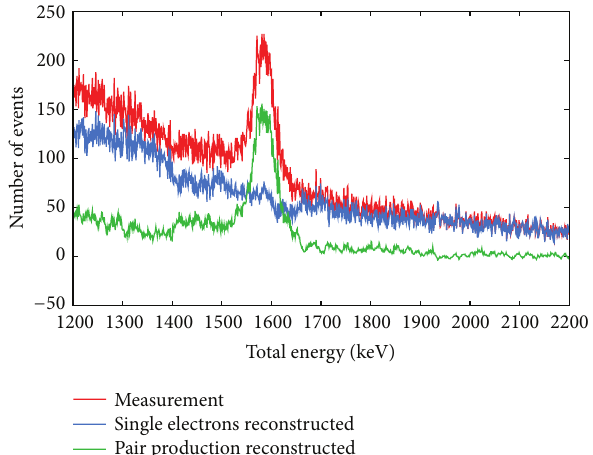
Figure 4: Red: reconstructed distribution of measured total energy depositions in tracks of a 1mm thick CdTe Timepix detector with 110 𝜇 m pixel pitch for irradiation with 2.614 MeV photons through its edge. Straight line tracks caused by muons and circular track structures caused by 𝛼 -particles have been removed before track analysis with the artificial neural network. Green: reconstructed total-energy distribution for events that should stem from pair production. Blue: reconstructed total-energy distribution of single- electron tracks.